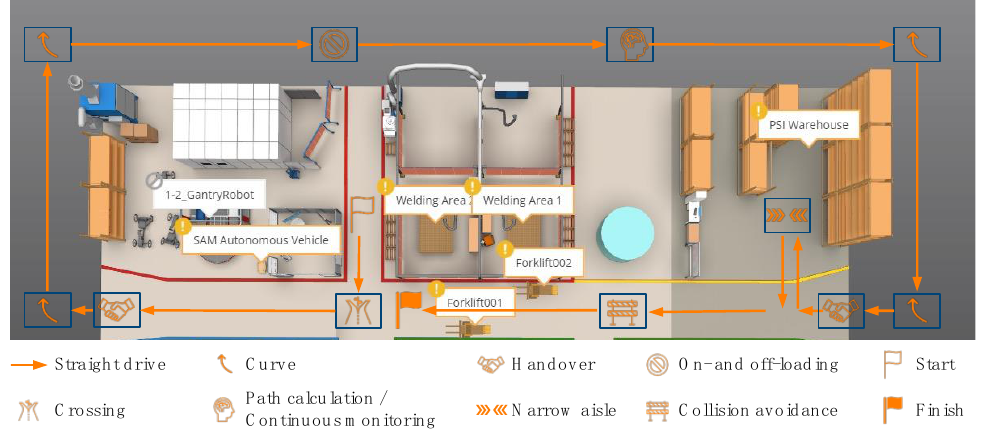
Figure 6. Layout of the AGV use case in the Digital Experience Factory Aachen.